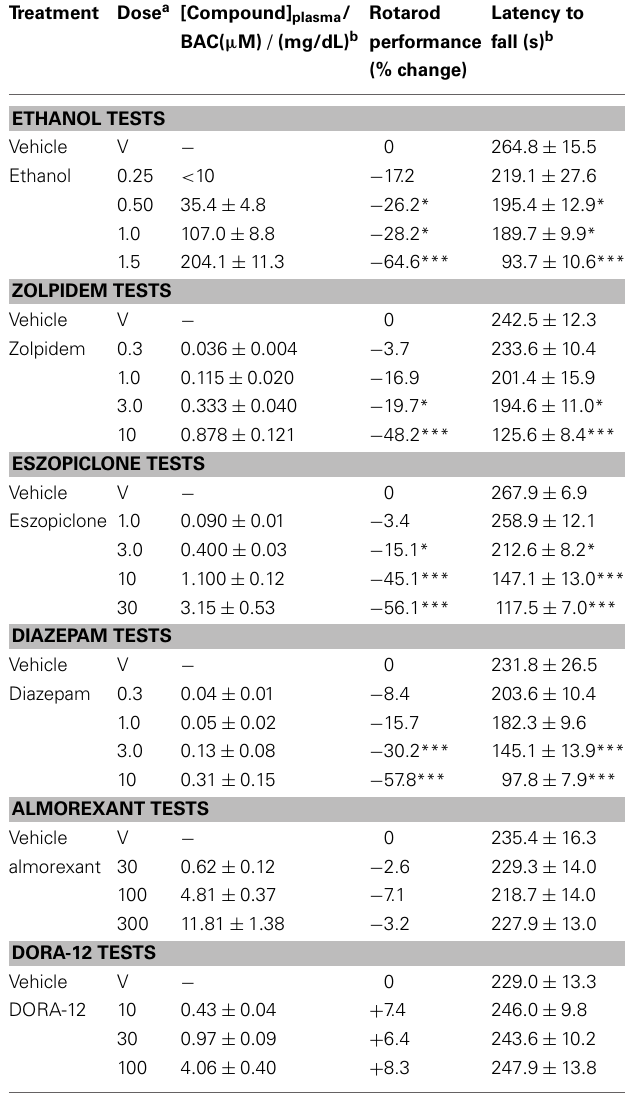
ANOVA, analysis of variance; SEM, standard error of the mean; V, vehicle Plasma/alcohol levels refer to time points between 35 and 40min after dosing of compounds. a Doses of zolpidem, eszopiclone and diazepam are given in mg/kg; doses of ethanol are given as g/kg. b Mean ± SEM shown for compound concentrations in plasma, blood alcohol concentrations (BAC) and Latency to fall. post-hoc Newman-Keuls multiple comparison